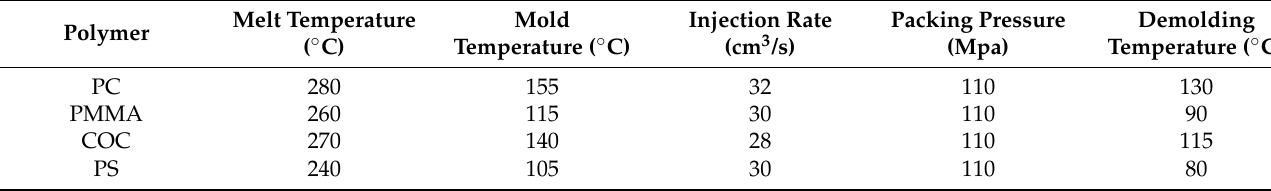
Table 2. Processing parameters of the injection molding experiments.